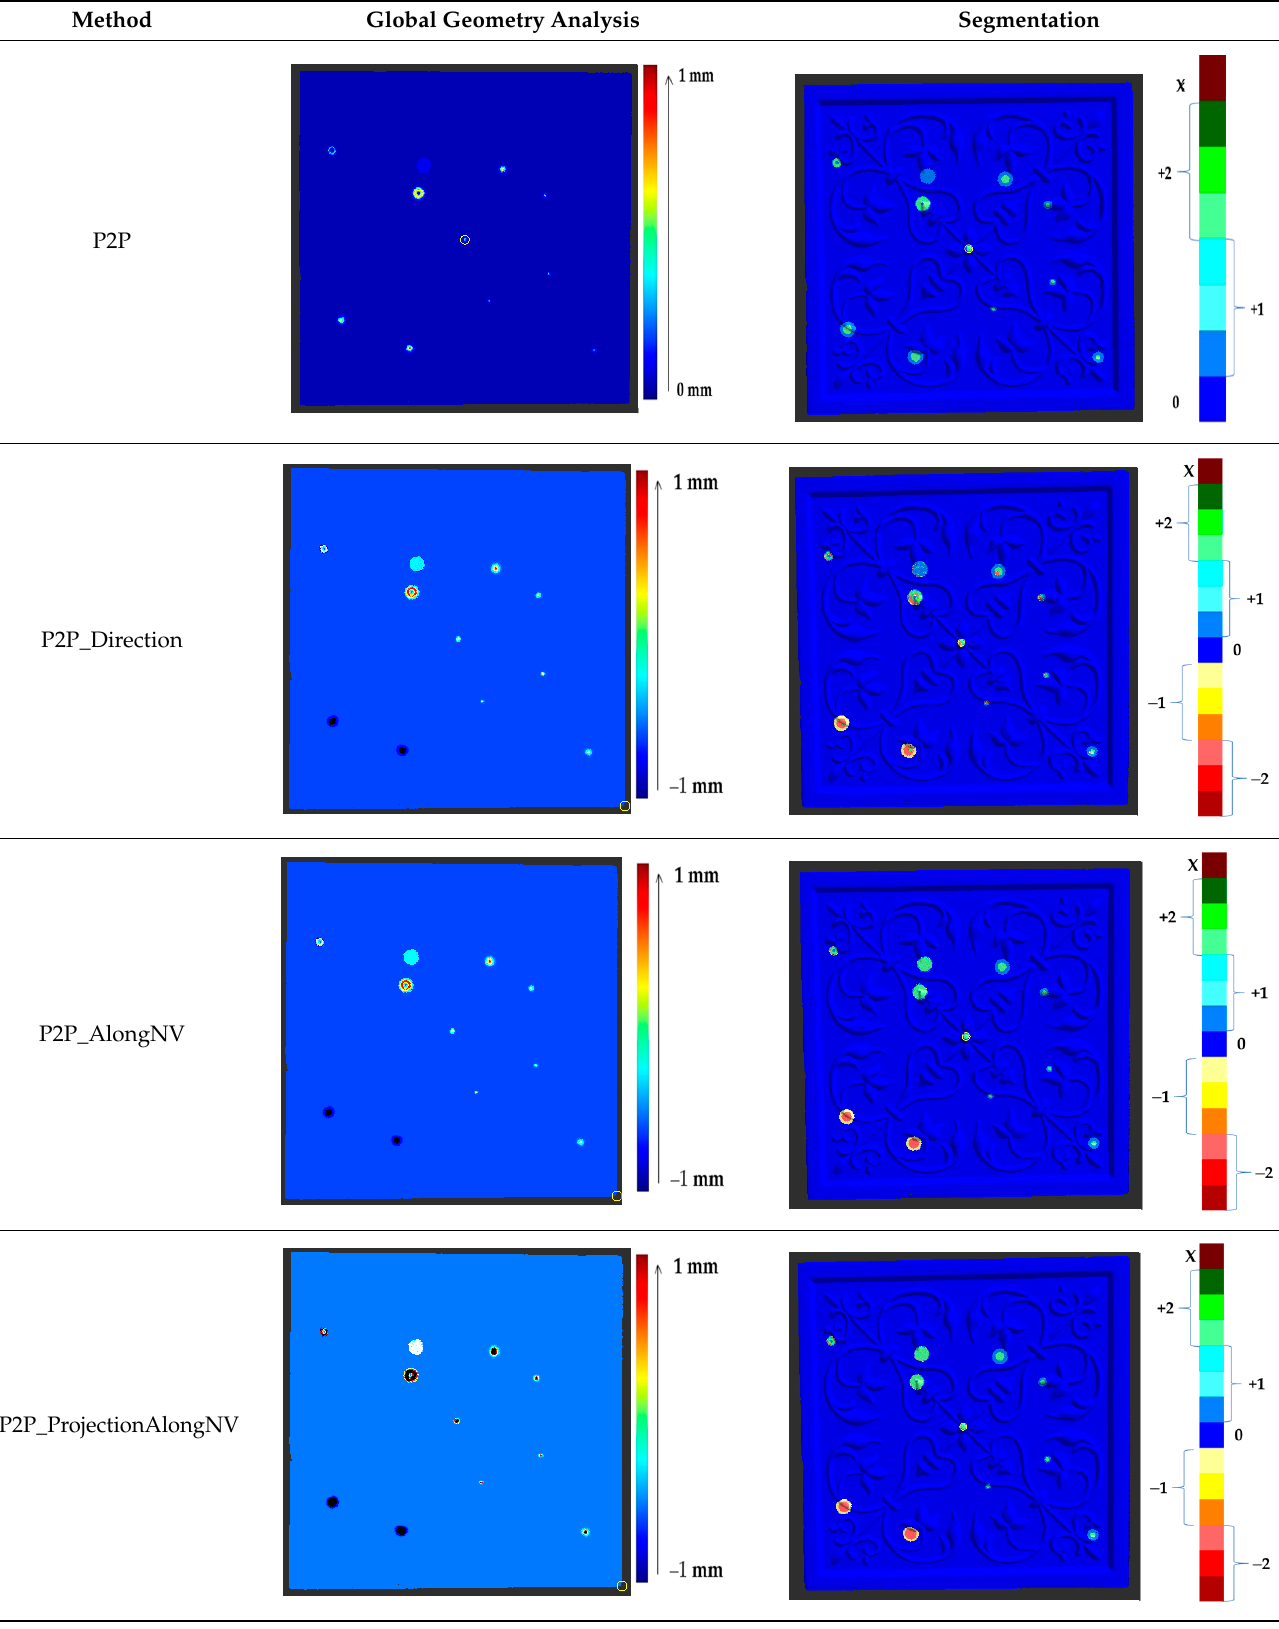
Table 6. Correctness of the ground truth table.